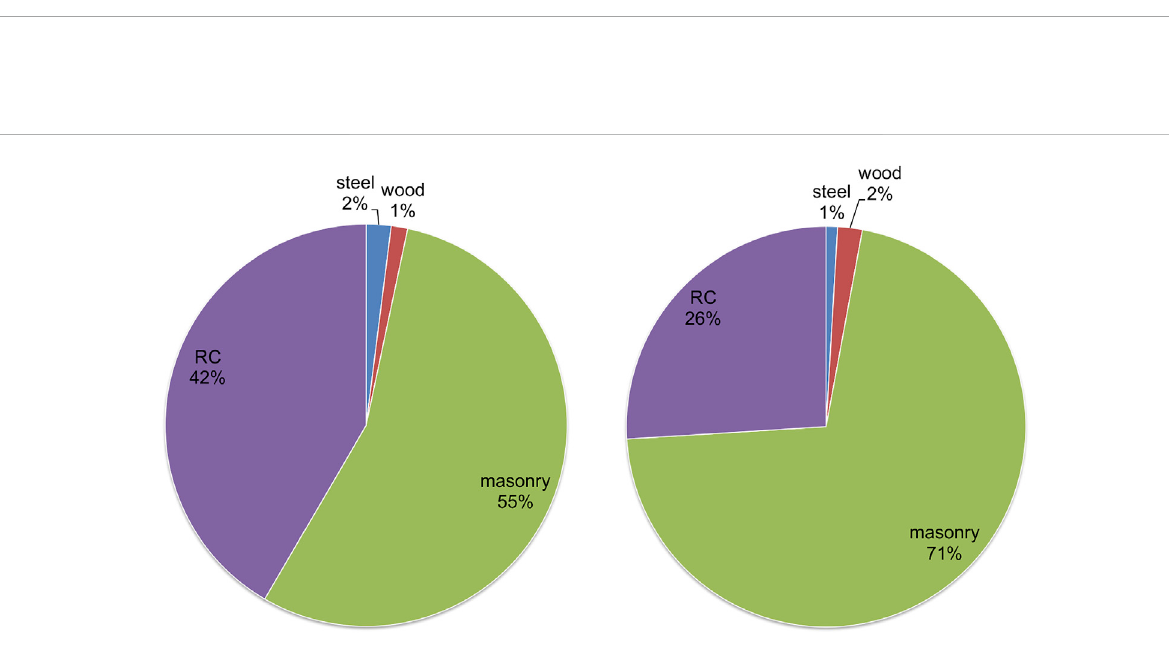
FIGURE 14 Overall updated distributions of building material for Sion (left) and Martigny (right).